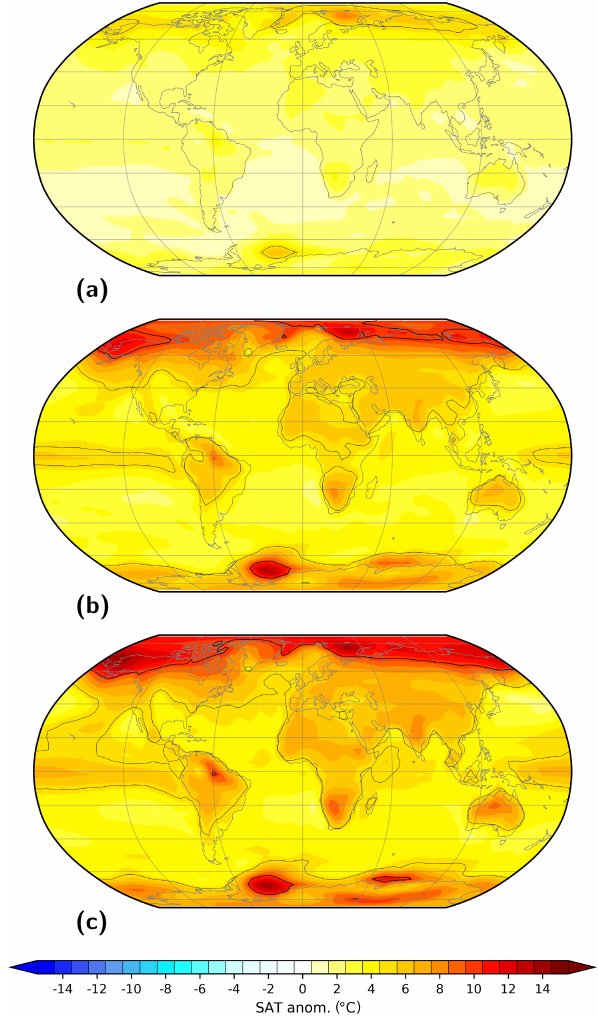
Figure 9. Sensitivity of annual mean surface air temperature (SAT) to variations in the volume mixing ratio of carbon dioxide (CO 2 ) for modern geography. Shown are anomalies with respect to pre- industrial (E280) for simulations (a) E400, (b) E560, and (c) E600. In hatched regions the anomaly is insignificant at the 95% confi- dence interval based on a t test. Contours illustrate isotherms of 5 ◦ C (solid, thin) and 10 ◦ C (solid). We define SAT as the tempera- ture at a height of 2m above the